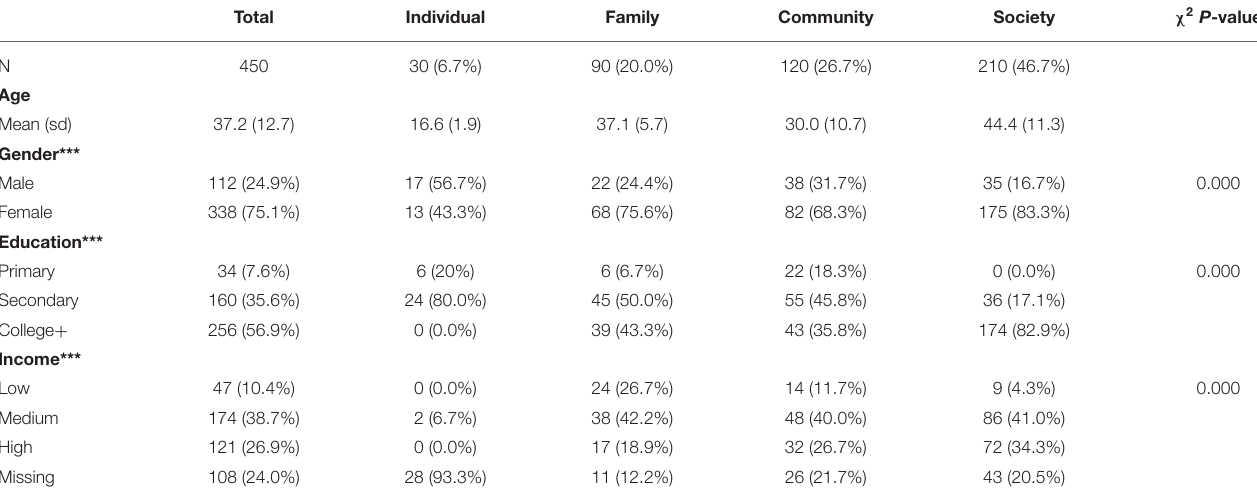
TABLE 2 | Demographics overall and by social ecological model